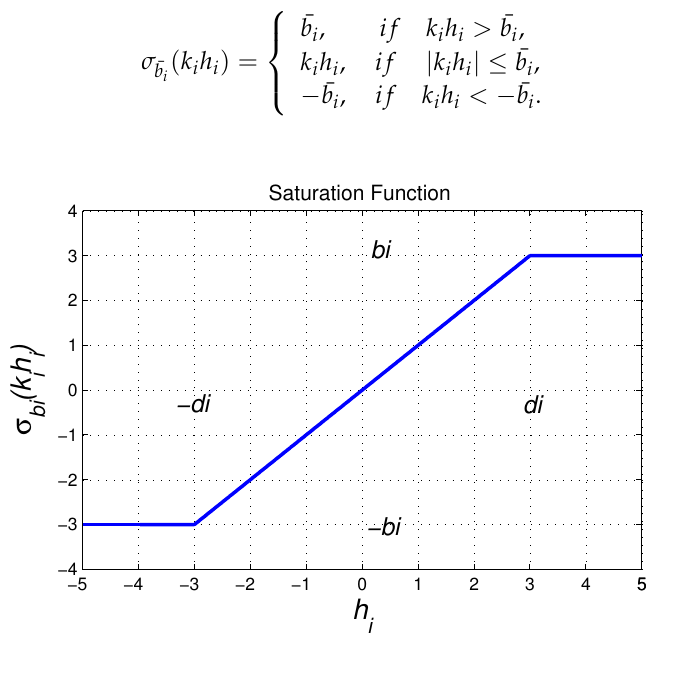
Figure 4. Saturated